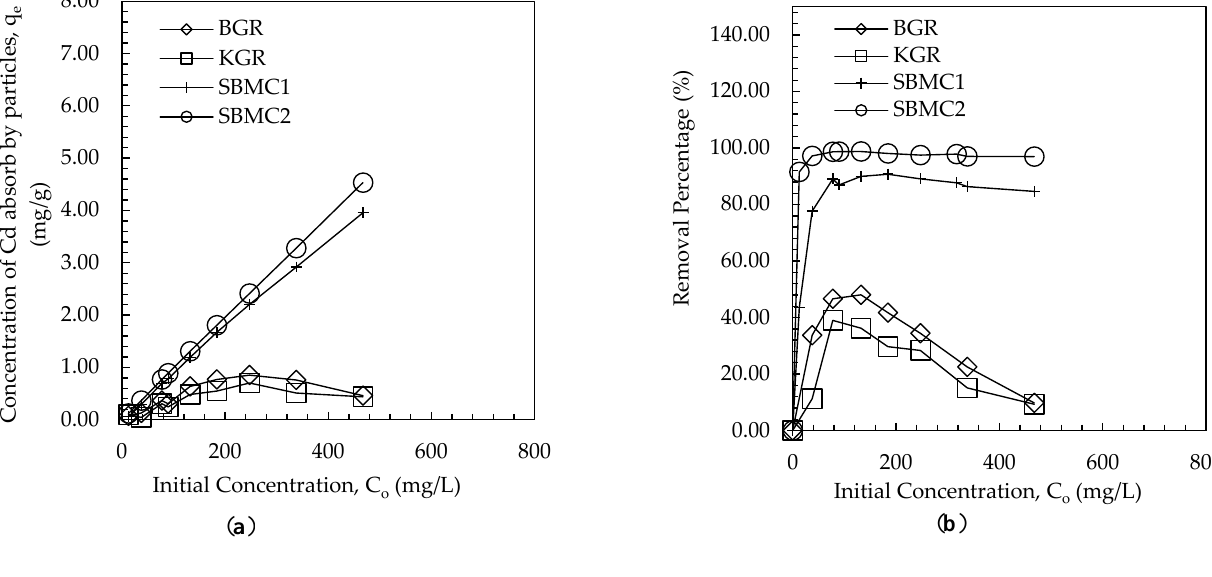
Figure 4. The ( a ) Effect of initial concentration on adsorption of Cd onto adsorbents [W: 4 g; V: 40 mL, t: 24 h] and ( b ) removal percentage.